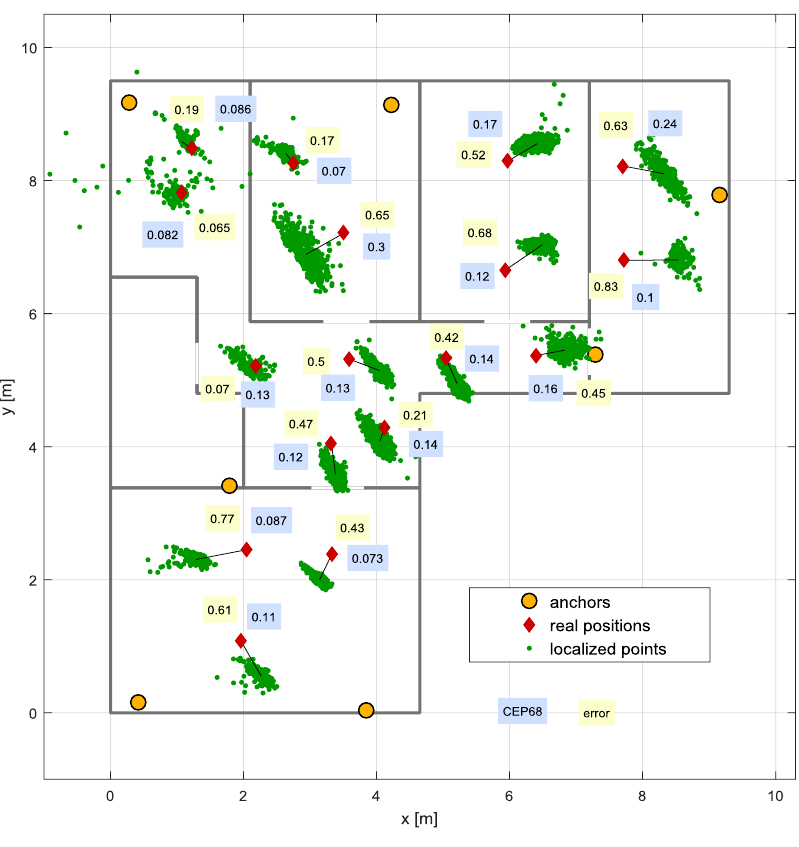
Figure 14. Positioning errors and Circular Error Probabilities (CEP) at particular test points. Sensors 2017 , 17 , 2092 16 of 21